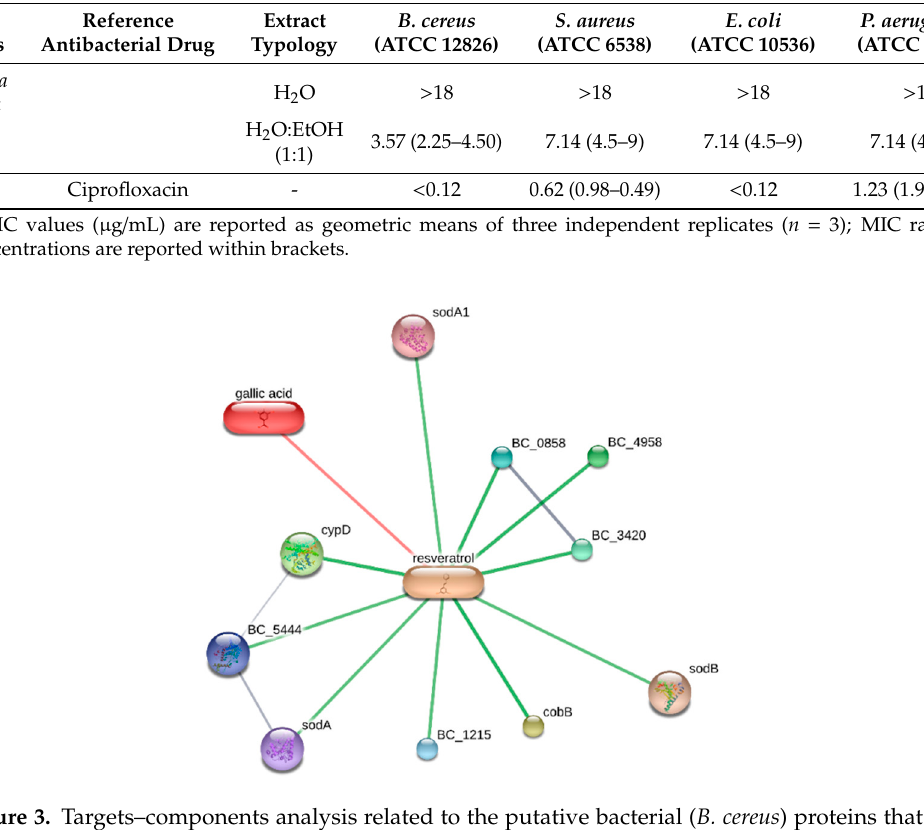
Figure 3. Targets–components analysis related to the putative bacterial ( B. cereus ) proteins that are principally targeted by resveratrol.